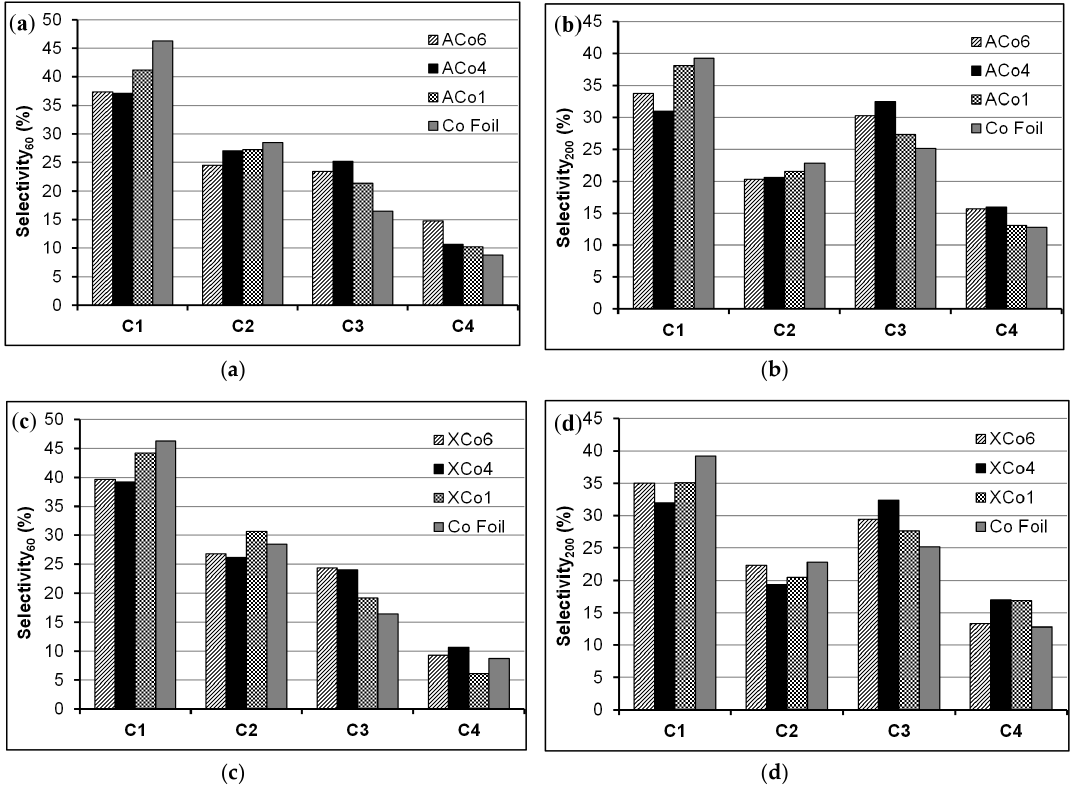
Figure 9. Product distribution (%) in terms of carbon selectivity in gas phase products after 60 ( a,c ) and 200 ( b,d ) min of reaction time for the aerogel ( a , b )- and xerogel ( c , d )-based electro-catalysts, respectively.